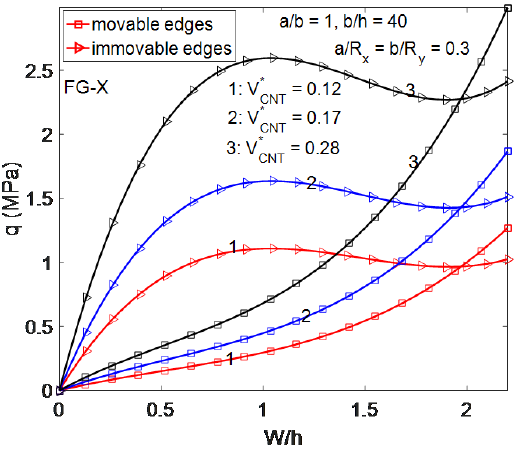
Fig. 8: Effects of imperfection and CNT volume fraction on the ex- tremum type buckling pressures of CNTRC spherical panels with immovable